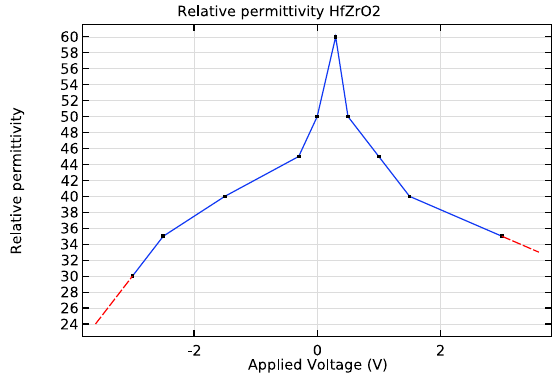
Figure 5. Relative permittivity of Hf 0.3 Zr 0.7 O 2 in function of applied